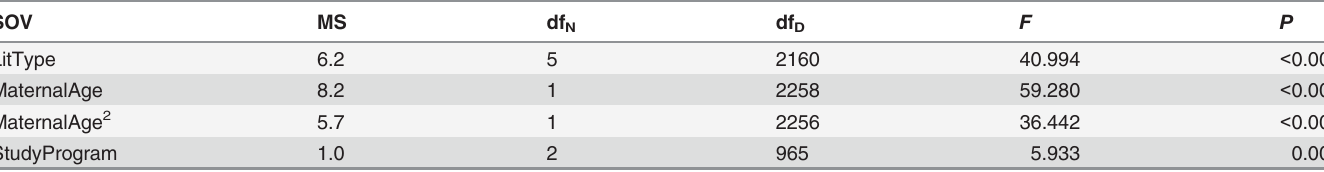
Table 4. Sources of variation utilizing restricted maximum likelihood estimation for a linear mixed-effects model assessing the influence of repro- ductive components on birth mass (kg) of singleton and twin white-tailed deer at Kerr Wildlife Management Area, Kerr County, TX from 1977 –